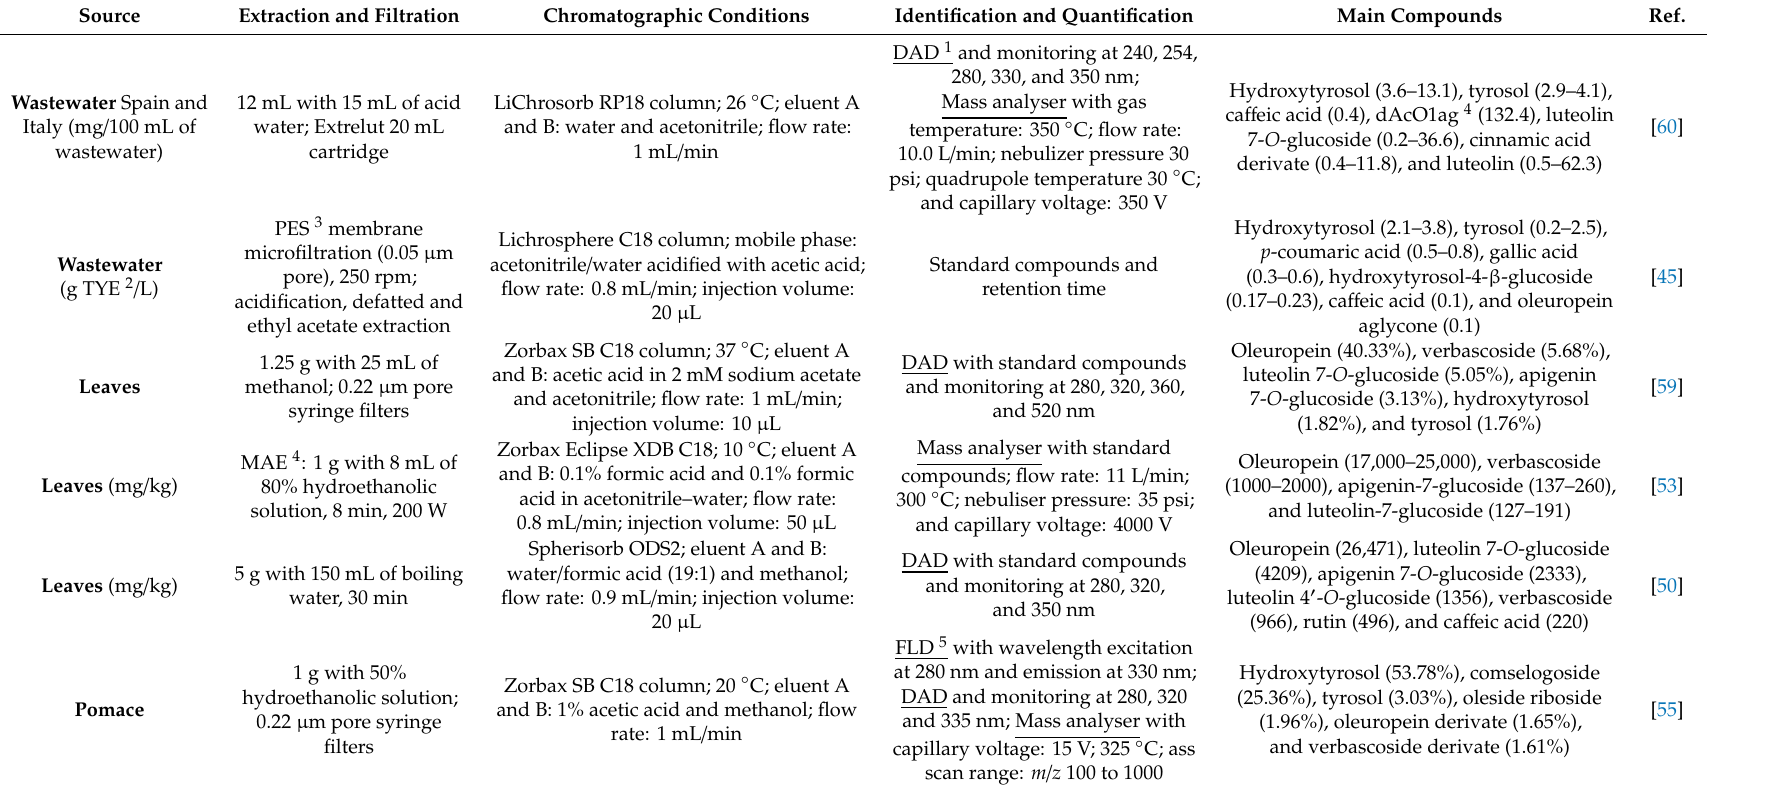
Table 1. Main phenolic compounds found in Olea europaea leaves, olive pomace and